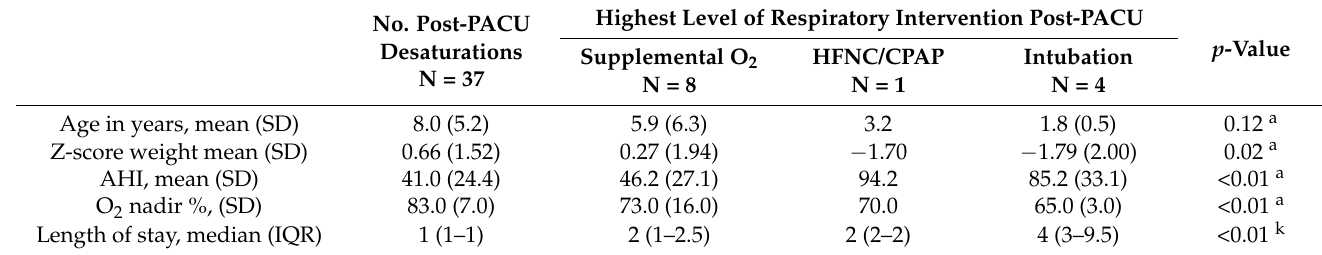
Table 3. Patient and pre-operative sleep study characteristics by occurrence of post-operative respira- tory interventions, stratified by post-operative respiratory